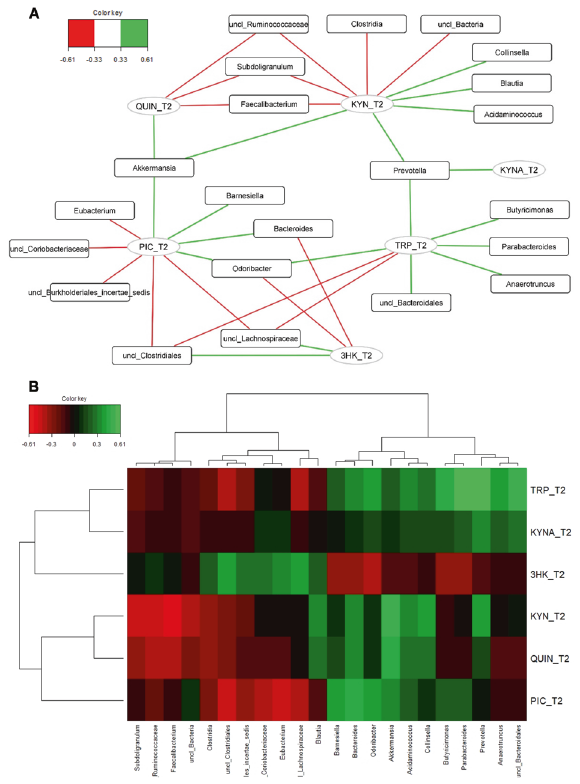
Fig. 4 Associations between tryptophan metabolites and intest- inal bacteria. A Relevance networks obtained for the fi rst three dimensions of the rCCA and generated with Cytoscape. Green and red edges indicate positive and negative correlations respectively, with a threshold = 0.33. Tryptophan metabolites and intestinal bacteria are represented respectively as circles and rectangles. B Clustered Image Map obtained for the fi rst three dimensions of the rCCA. The green and the red colors indicate positive and negative correlations respectively, with a threshold = 0.33, whereas black indicated small correlation